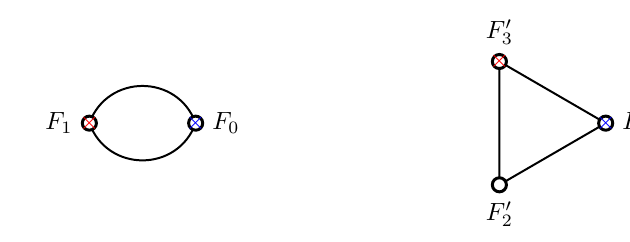
Figure 1 . Schematic diagram of the singular elliptic fibers over the codimension-one su (2) (left) and su (3) (right) loci of the discriminant locus in B . Over the su (2) locus d = 0 , the singular 0 e 1 elliptic fiber F is Kodaira type I , and admits the decomposition F = F + F ; over the su (3) 2 0 1 locus b = 0 , the singular elliptic fiber is Kodaira type I split , and admits the decomposition 1 e 2 e 3 3 + F 0 + F 0 . Note that all irreducible components F are rational curves. The blue × 0 F = F 0 a , F 0 2 3 b indicates that F intersect the zero section ˆ D in a point, whereas the red × symbol indicates 0 0 , F 0 0 that F intersect the generating section ˆ D in a 0 1 , F 1 3